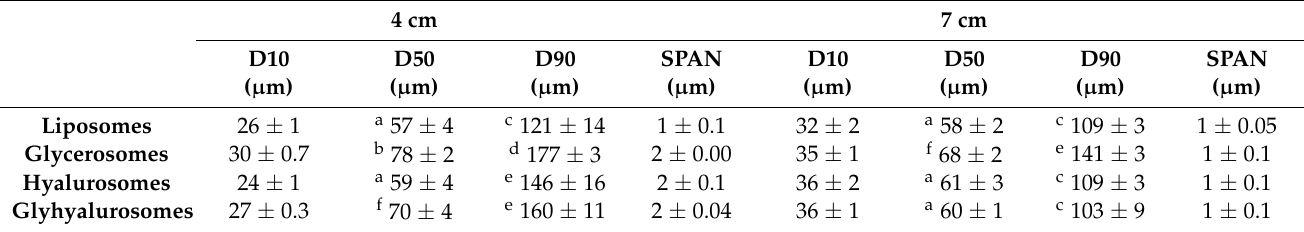
Table 2. Droplet size analysis of Z. officinalis vesicles sprayed from a distance of 4 and 7 cm from the laser beam. Standard deviation (±) is expressed as the mean of 3 measurements. Each symbol (a, b, c, d, e, f) indicates the same value.